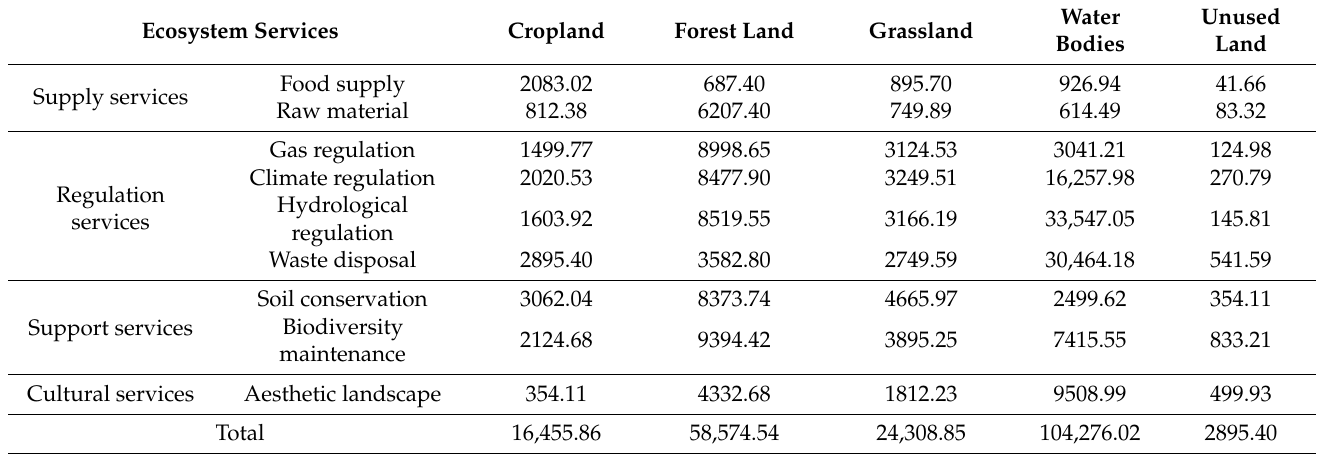
Table 2. ESV coefficient of different land use type in the YRB (CNY · km − 2 · a − 1